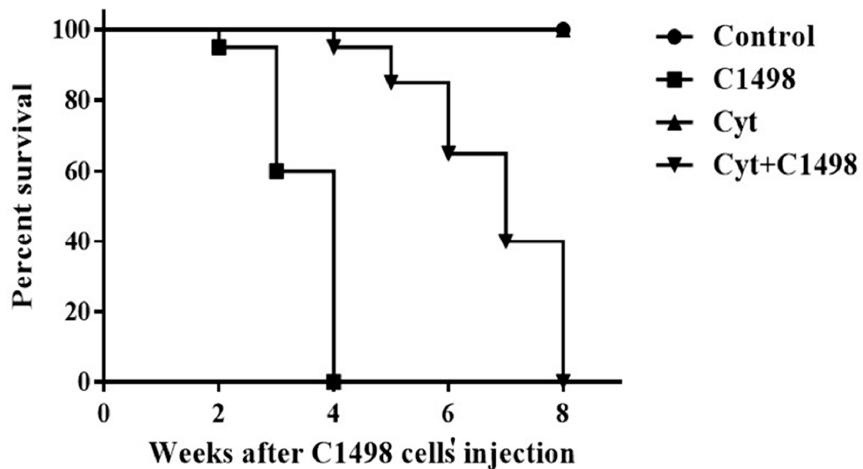
Figure 1. Effect of AML cells, cytarabine, and the combination of both on mice survival: Adult C57/black mice were injected with PBS (control), C1498 cells (C1498), cytarabine (Cyt), or with a combination of both (Cyt + C1498). The survival of mice was evaluated 2–8 weeks after injection (see the Methods) in intervals of one week. The results are representative of four independent experiments with 10 mice in each group.